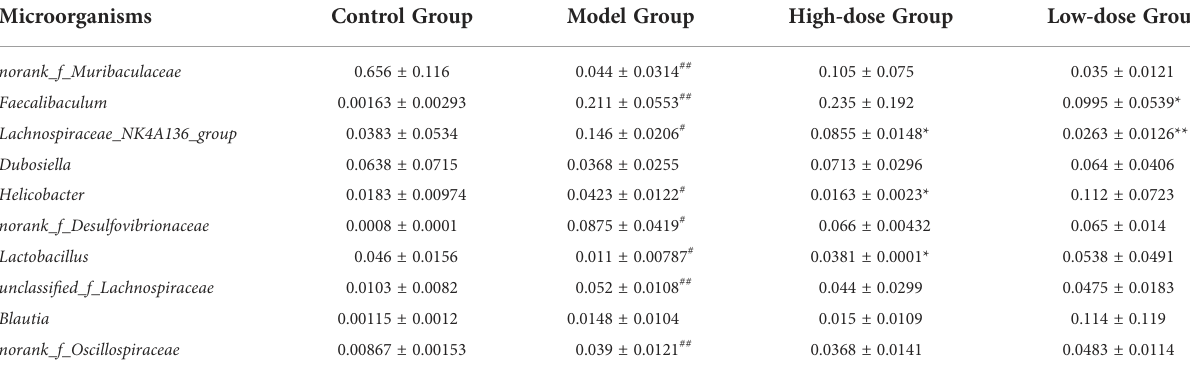
TABLE 1 Changes of the gut microbiota in the top 10 relative abundances at the genus level.